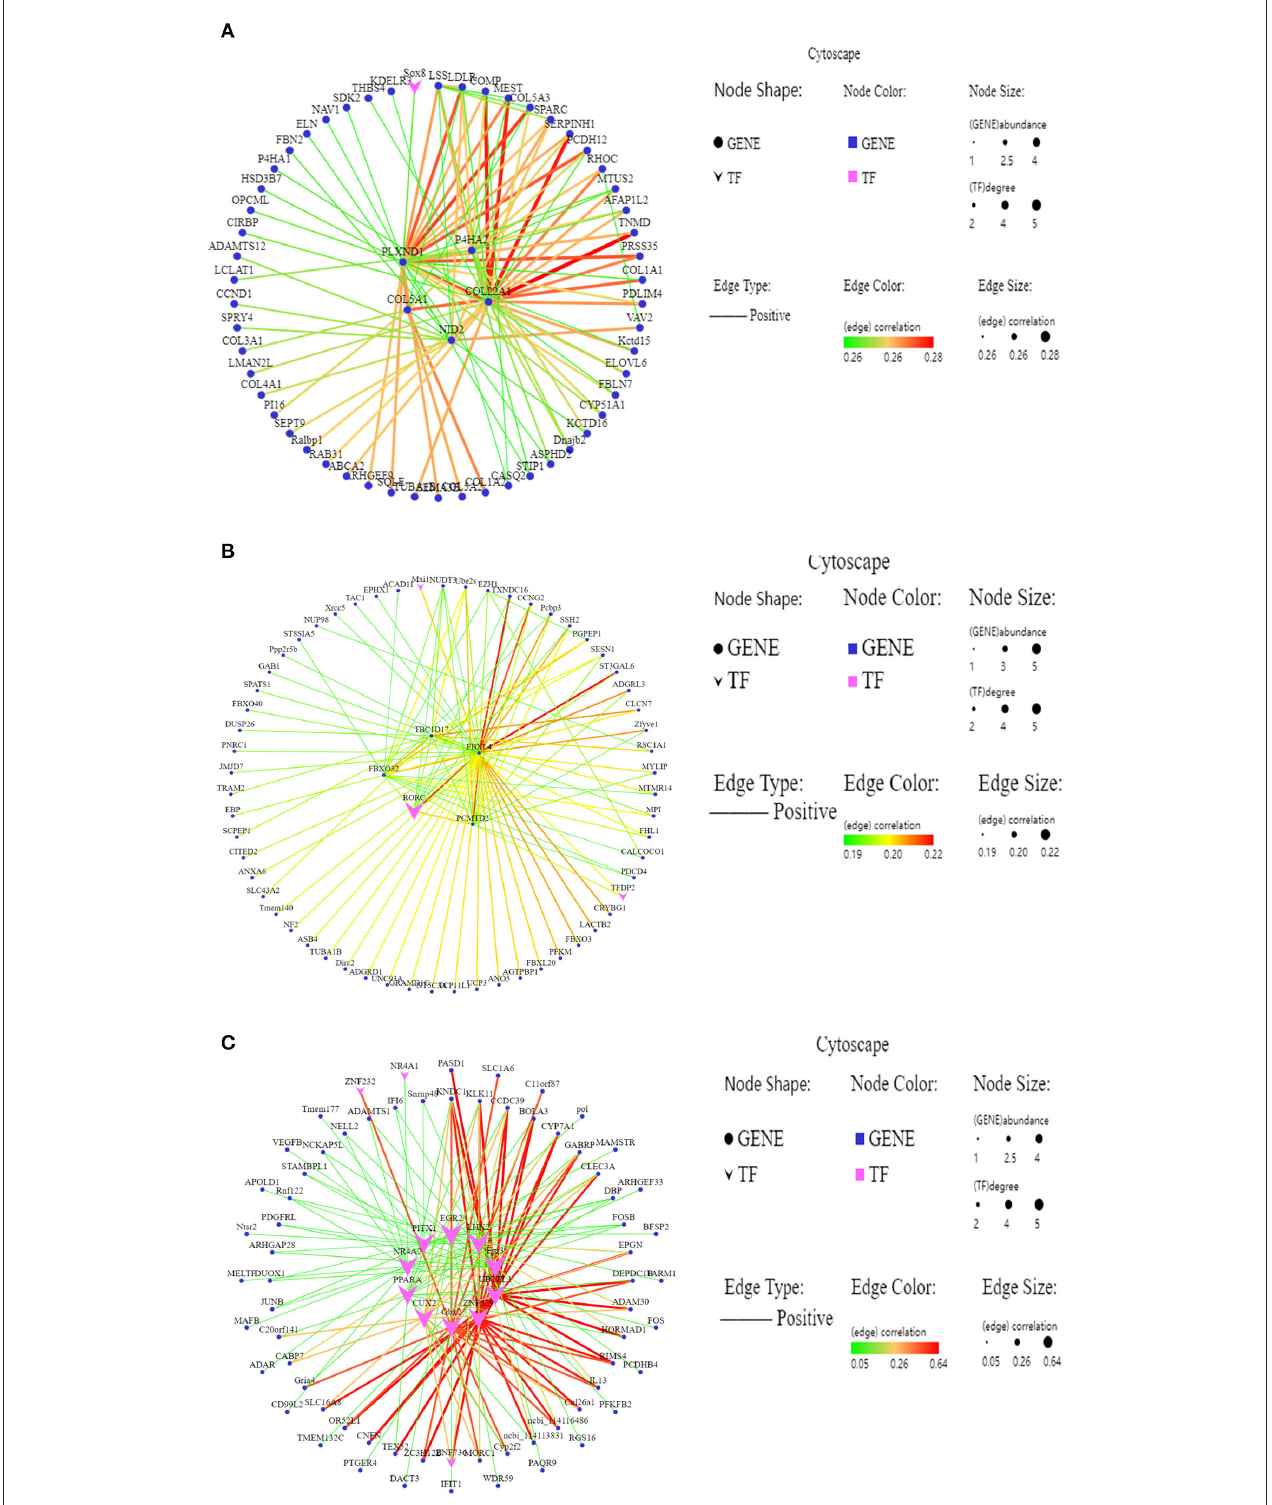
FIGURE 5 | The gene co-expression regulatory interaction network. (A–C) Gene co-expression network of the MM.green module, MM.grey60 module, MM.dark-red module, respectively. Larger and darker colors in large lines in the corresponding network indicate genes with higher connectivity; vee represents transcription factors; ellipse represent other